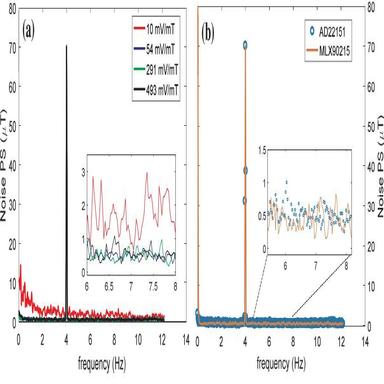
(a) Signal-to-noise ratio graph for a 4 Hz signal at sensitivities of 10–493 mV/mT; the magnified view shows a comparison of the noises in the range of 6–8 Hz. (b) Comparative signal-to-noise ratio graph of the two sensors; the magnified view shows a comparison of the noises in the range of 5–6.5 Hz.